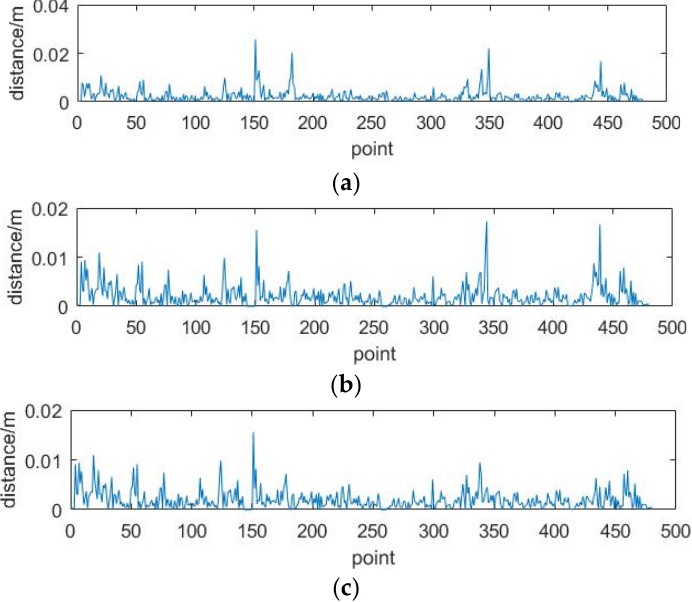
Figure 13. Environmental similarity error curves of different algorithms: ( a ) PDBS algorithm; ( b ) IEPF algorithm; ( c ) Proposed algorithm. Table 3. Comparison of Feature Point Extraction